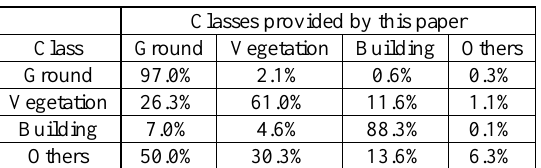
Table 1. Classification